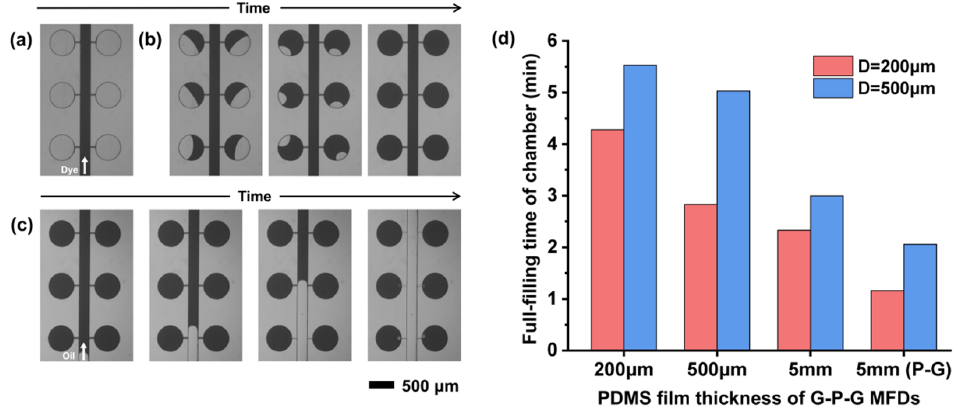
Figure 6. Sample filling and self-partition: ( a ) the food dye injection at 40 mBar. ( b ) Filling the chambers with the food dye at 500 mBar. ( c ) Process of the fluorinated oil pushing the excess reagent out of the main channels. ( d ) Filling time of chambers in the G-P-G MFD with different diameters and PDMS thicknesses.